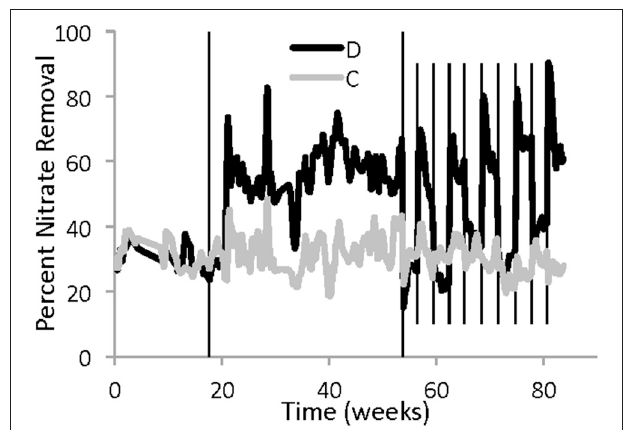
FIGURE 2 | Five-day average percentage of nitrate removal in each reactor between April 3, 2011 and November 8, 2012. The gray line represents the reactor with constant operation, while the black line is from the disturbed reactor. The solid vertical lines indicate a change in water level in the disturbed reactor due to alternating low and high weirs. During Phase I, both reactors had the same high water level, while during Phase II the disturbed reactor had approximately half the water height. During Phase III the water height in the disturbed reactor alternated between high and low every 3 weeks. Six sampling dates were excluded because of operational problems that resulted in changes to the influent concentration.